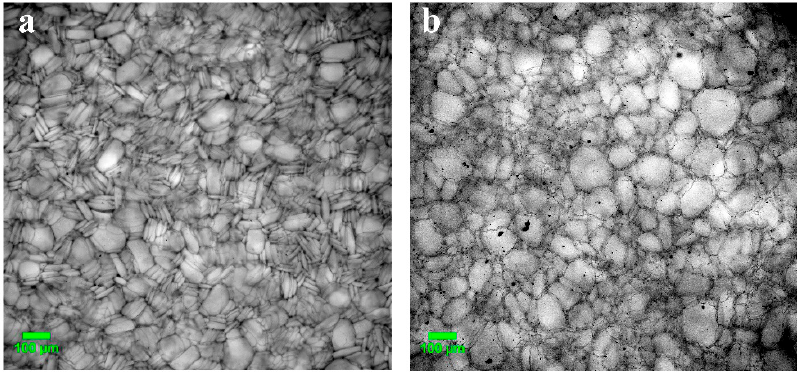
Figure 2. Microphotographs of the water ‐ swollen gelatin ‐ based cryostructurates tanned with EDC ( a ) or GXL ( b ). Optical microscope (see Section 4.4), phase contrast, Giemsa staining; scale bar = 100 μ m.